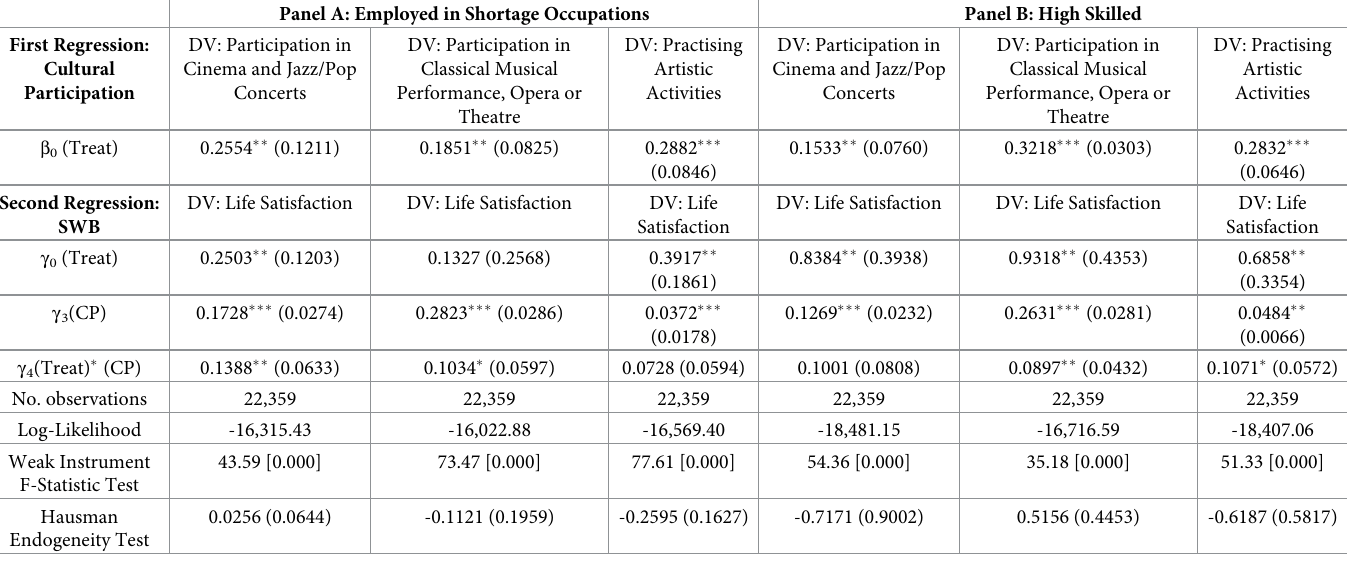
Table 8. FRDD estimates full sample. Panel A: Employed in Shortage Occupations Panel B: High Skilled